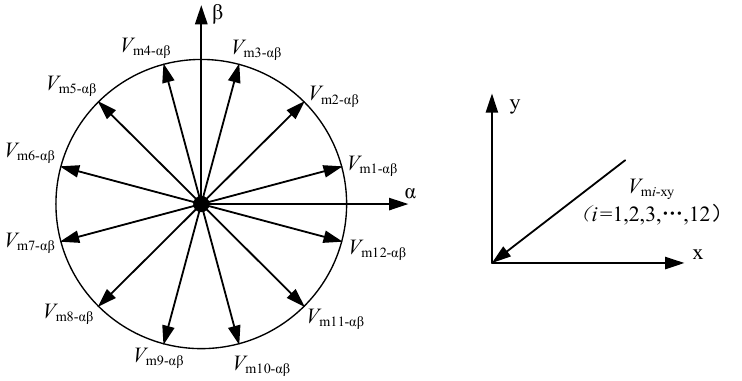
Figure 5. Distributions of the virtual vectors on different subplace.